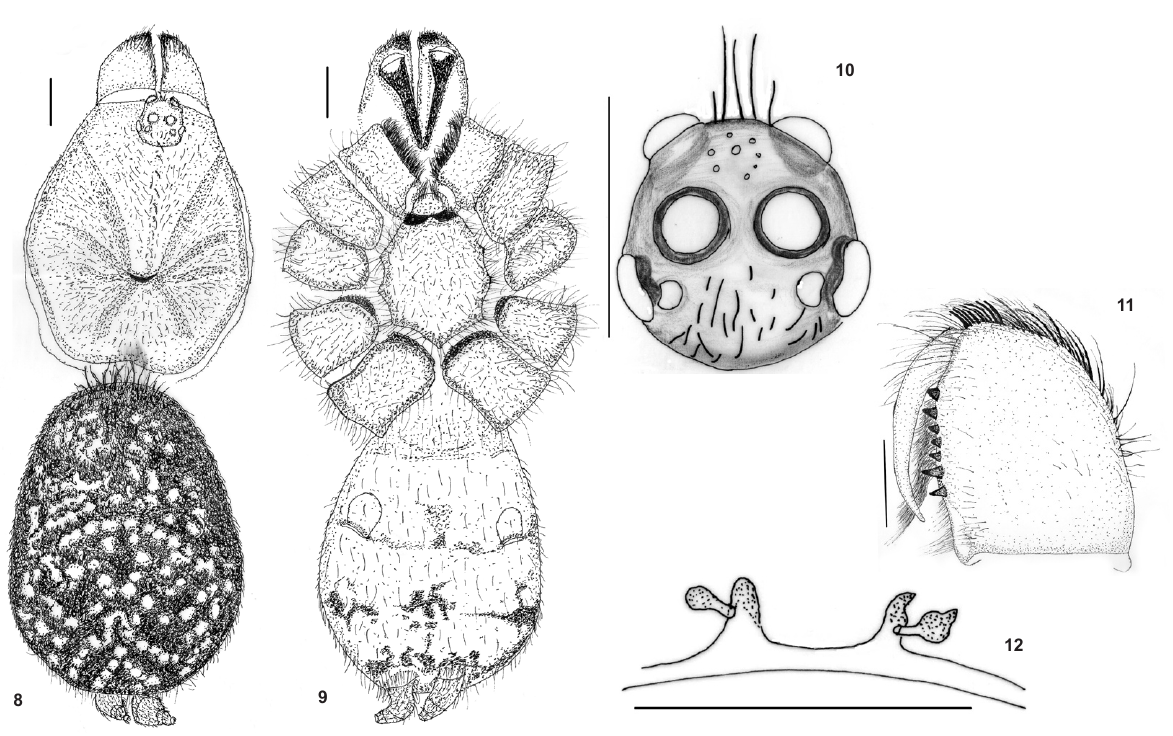
Table 3. Morphometry of legs and palp of T. nilgiriensis sp. nov. holotype female (WILD–11–ARA–1110) and T. rutilofronis sp. nov. holotype female (WILD–11–ARA–1111) and paratype female (WILD–11–ARA–1112). Measurements in mm.